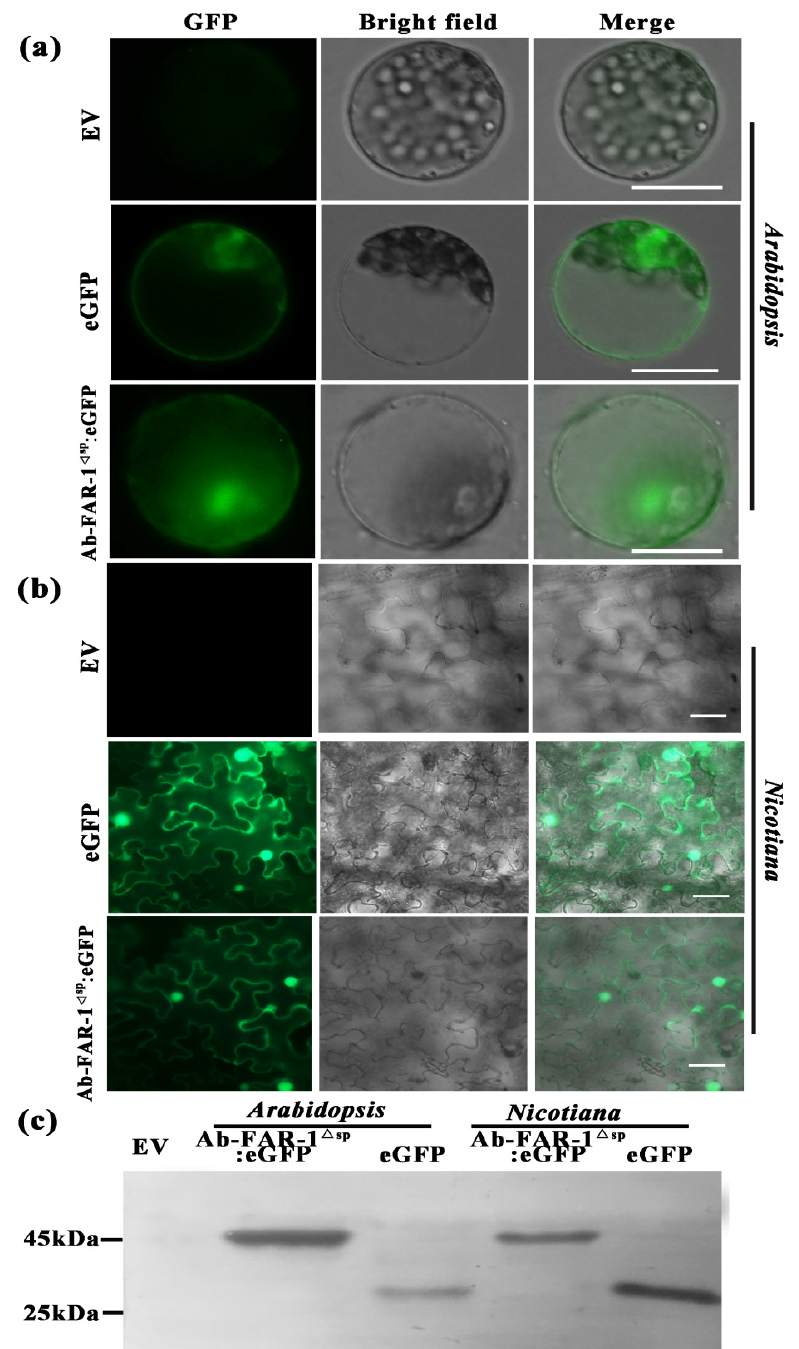
Figure 3. Subcellular localisation of Ab-FAR-1 ∆ sp in protoplast cells of Arabidopsis thaliana and leaves of Nicotiana benthamiana. ( a , b ) The fusion proteins were expressed in protoplast cells of A. thaliana and leaves of N. benthamiana . Fusion protein of Ab-FAR-1 ∆ sp :eGFP and free eGFP signal were localised to the cytoplasm and nucleus. ( c ) The band size of each fusion protein was consistent with the size predicted by Western blot. EV, empty vector. Bar = 50 µ